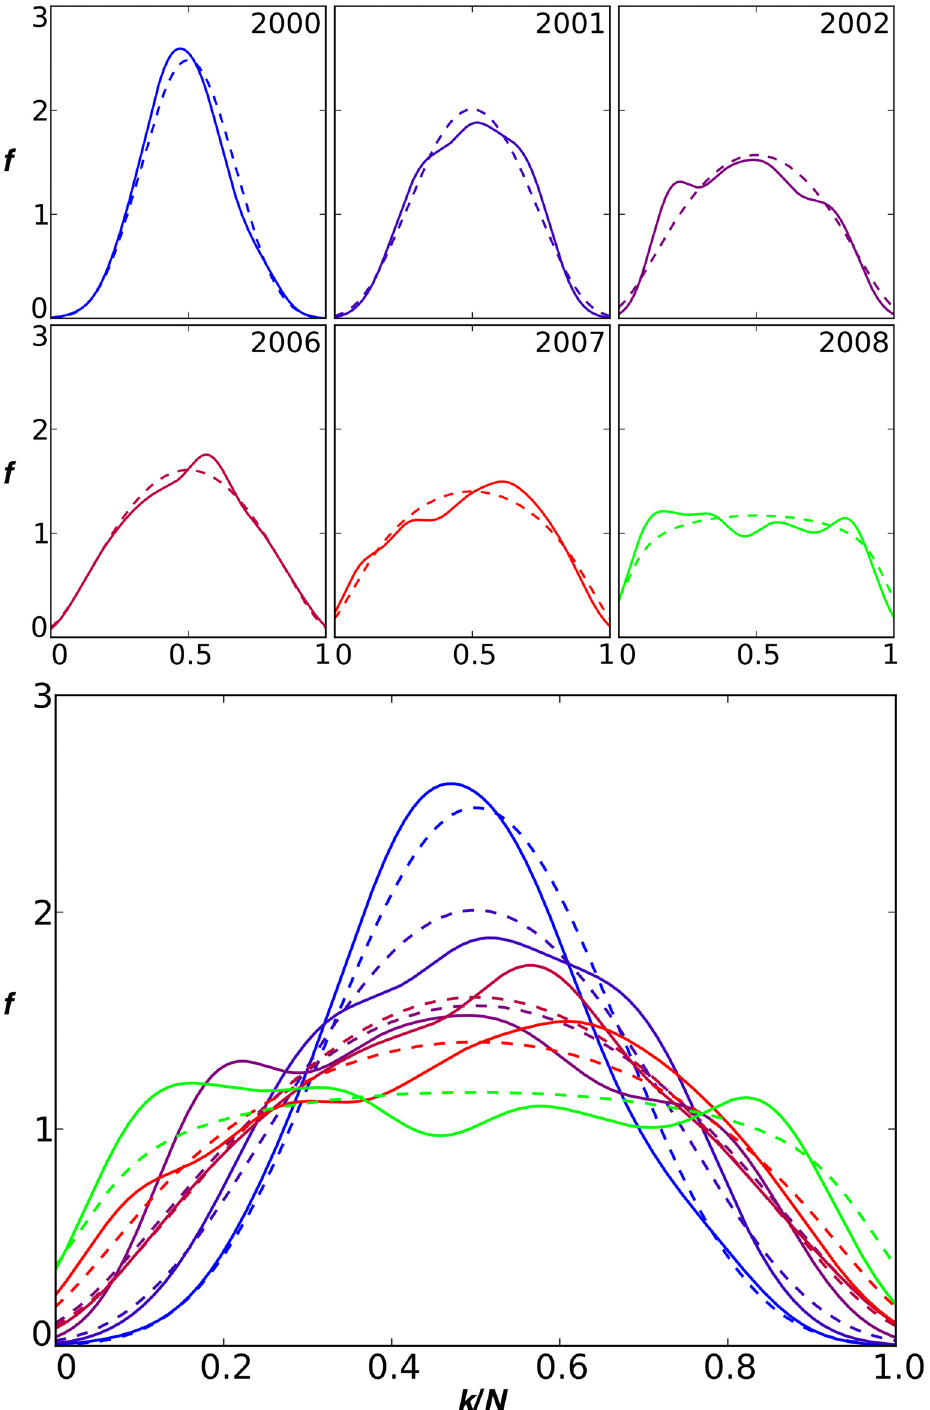
Fig 1. The co-movement of stocks. Plotted is the fraction of trading days during the year ( f , vertical axis) in which a certain fraction of stocks ( k / N , horizontal axis) moved up. Empirical data are shown (solid lines) along with one-parameter theoretical fits (dashed lines) for the years indicated. Three years are omitted that do not differ much from the year immediately preceding and after them. Bottom panel combines all of the years shown. Stocks included are from the Russell 3000 that trade on the NYSE or Nasdaq. Curves are kernel density estimates with Gaussian kernels ( σ = 0.06). Fits pass the χ 2 goodness-of-fit test (the deviation of the data from the theoretical distribution is not statistically significant at the 25%